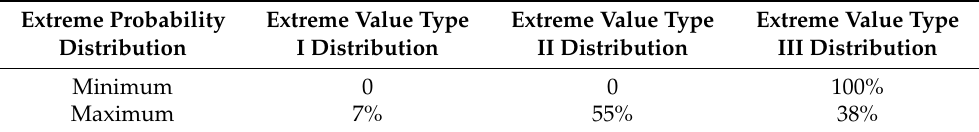
Figure 8. Ratio of D K the Gumbel distribution to the D K of GEV distribution. ( a ) Minimum pressure coefficient; ( b ) Maximum pressure coefficient. Table 2. Proportion of each probability distribution.